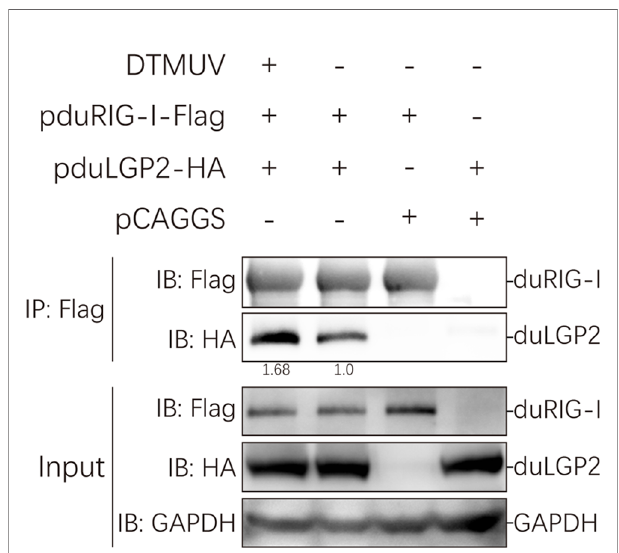
FIGURE 8 | duLGP2 interacts with duRIG-I. HEK 293 cells were transiently co-transfected with indicated expression plasmids or empty plasmids pCAGGS. Cells were infected with DTMUV or PBS at 24 hpt and lysed at 24 hpi. Immunoprecipitates were analyzed by Western blot with the indicated antibodies, and the relative gray values of the bands were calculated using the ImageJ